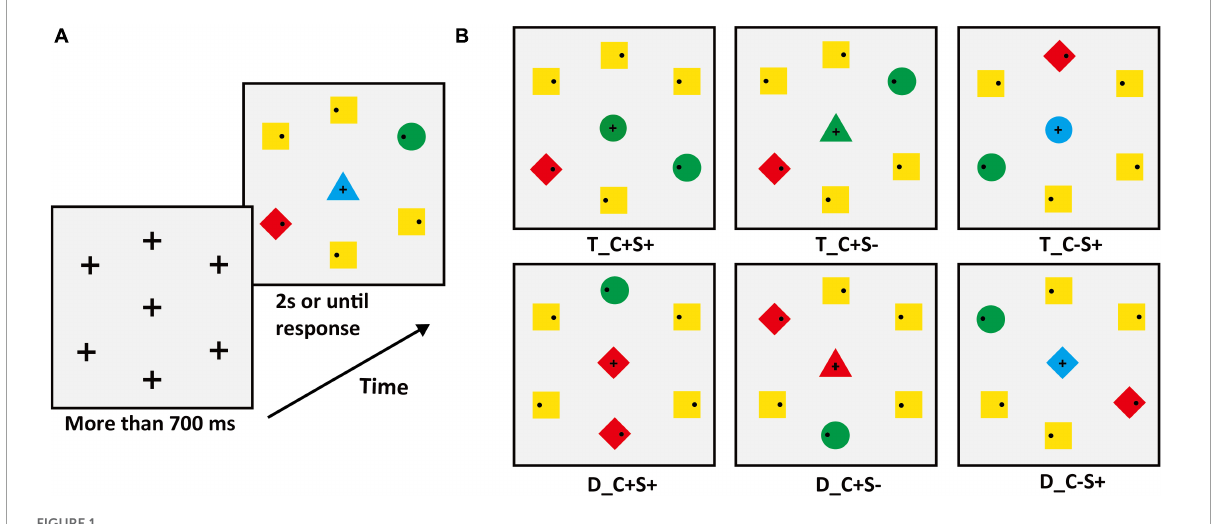
FIGURE1 (A) Schematic procedure of Experiment 1A (e.g., target: green circle). The second search display was the baseline condition. (B) The condition of the center stimuli. T_ = the center stimulus shares features with the target, D_ = center stimulus shares features with salient distractor; C = color, S = shape; the “ + ” stands for same, “–” stands for